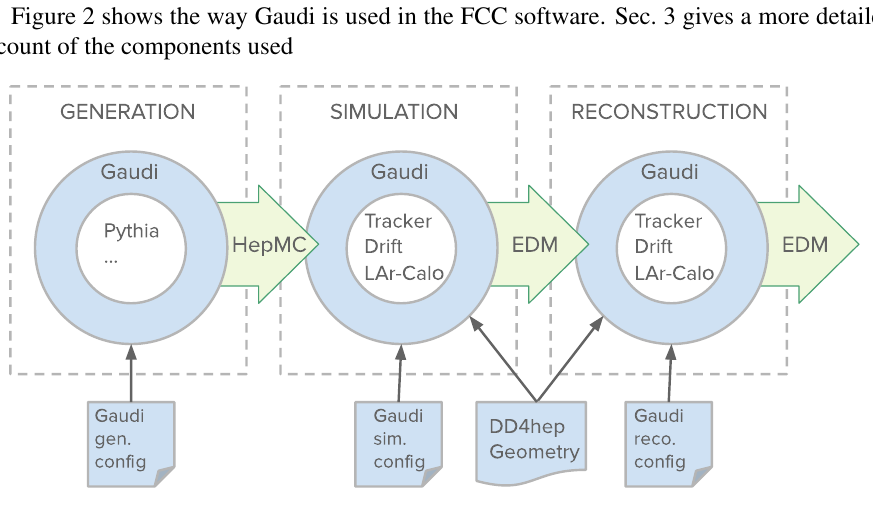
Figure 2. Schema of the organisation of Gaudi components in FCCSW, their steering and the data